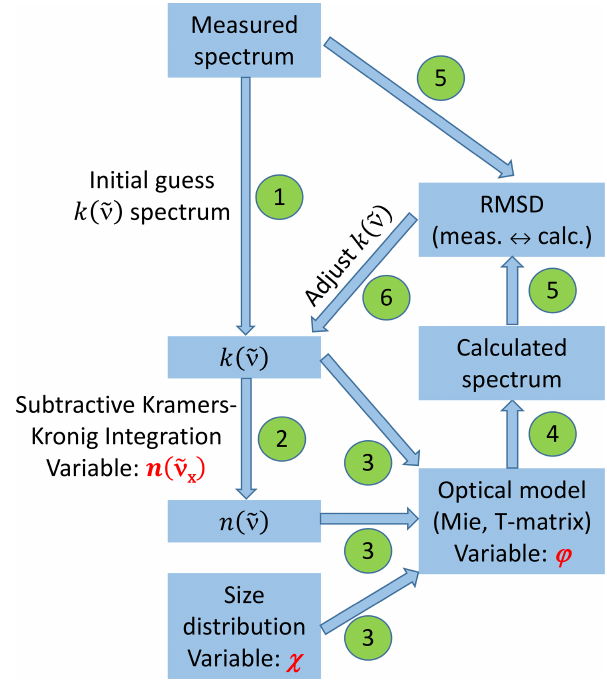
Figure 3. Flowchart of the retrieval scheme to deduce the optical constants of the crystalline AN particles. All abbreviations, sym- bols, and steps in the procedure (numbered green circles) are ex- plained in Sect.